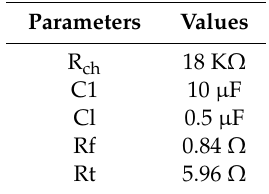
Table 1. Parameters for standard lightning impulse generator